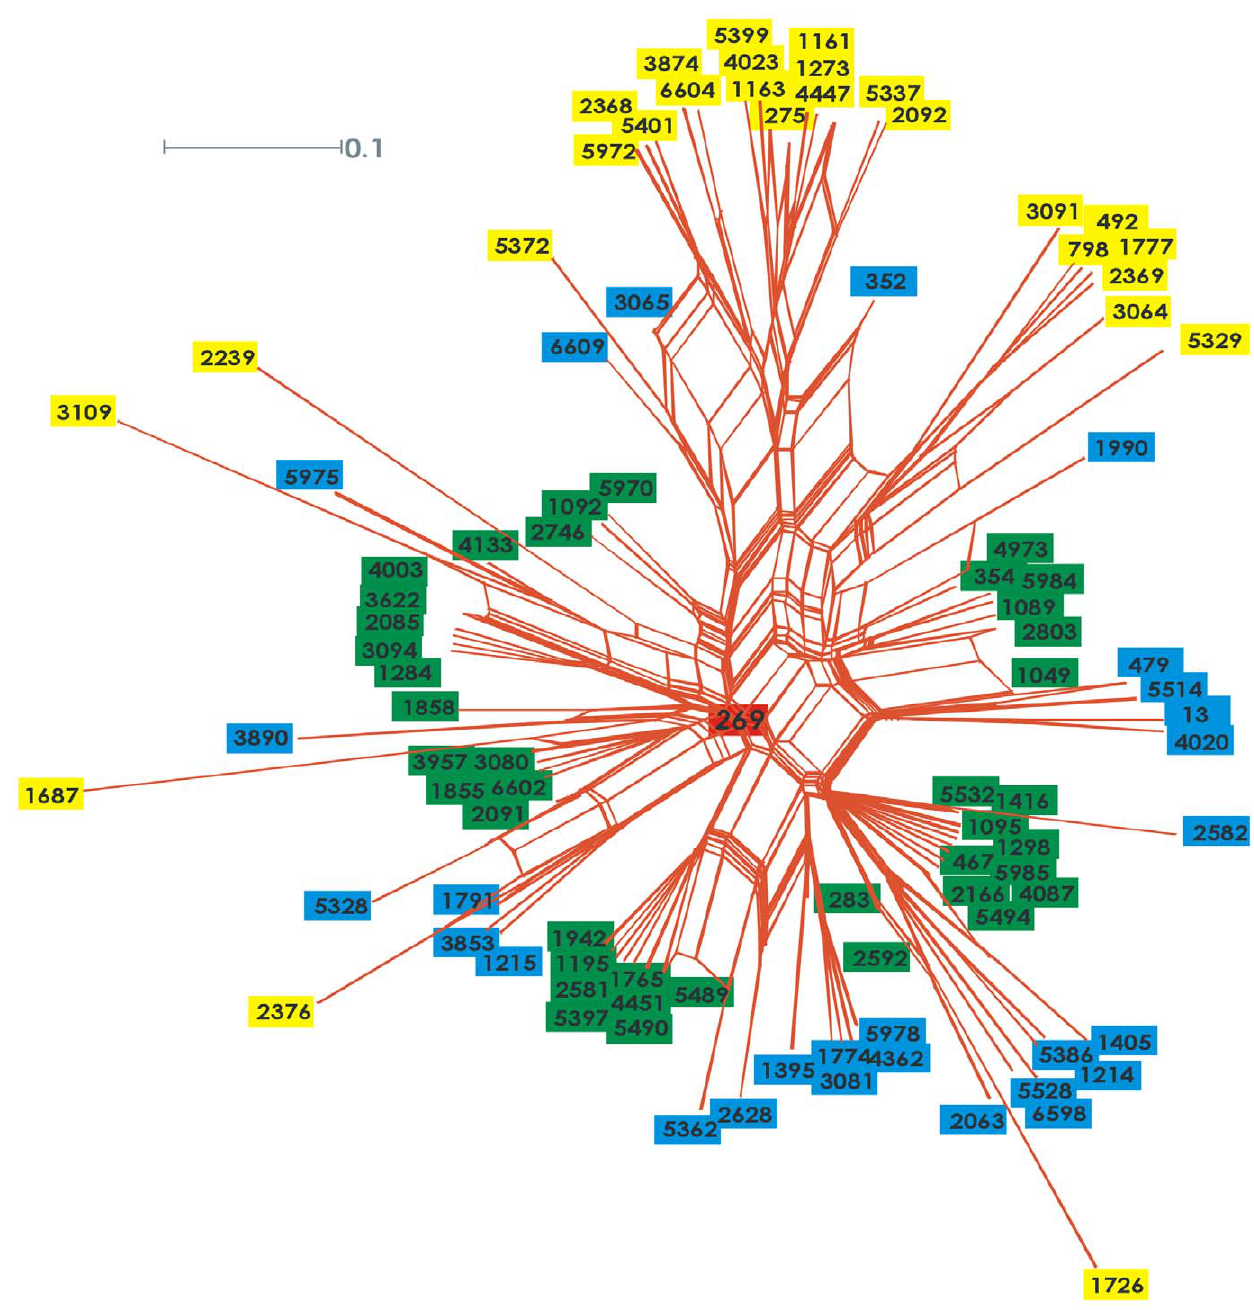
Figure 4. Genetic relatedness between STs within cc269. Neighbor-net constructed from the concatenation of the seven MLST housekeeping genes of N. meningitidis [4]. The major groupings (indicated with green, black, and yellow circles) represent the number of allelic differences (1, 2 and 3 respectively) from the core ST-269 allelic profile. The tree was made using the Split-Tree4 software [29].